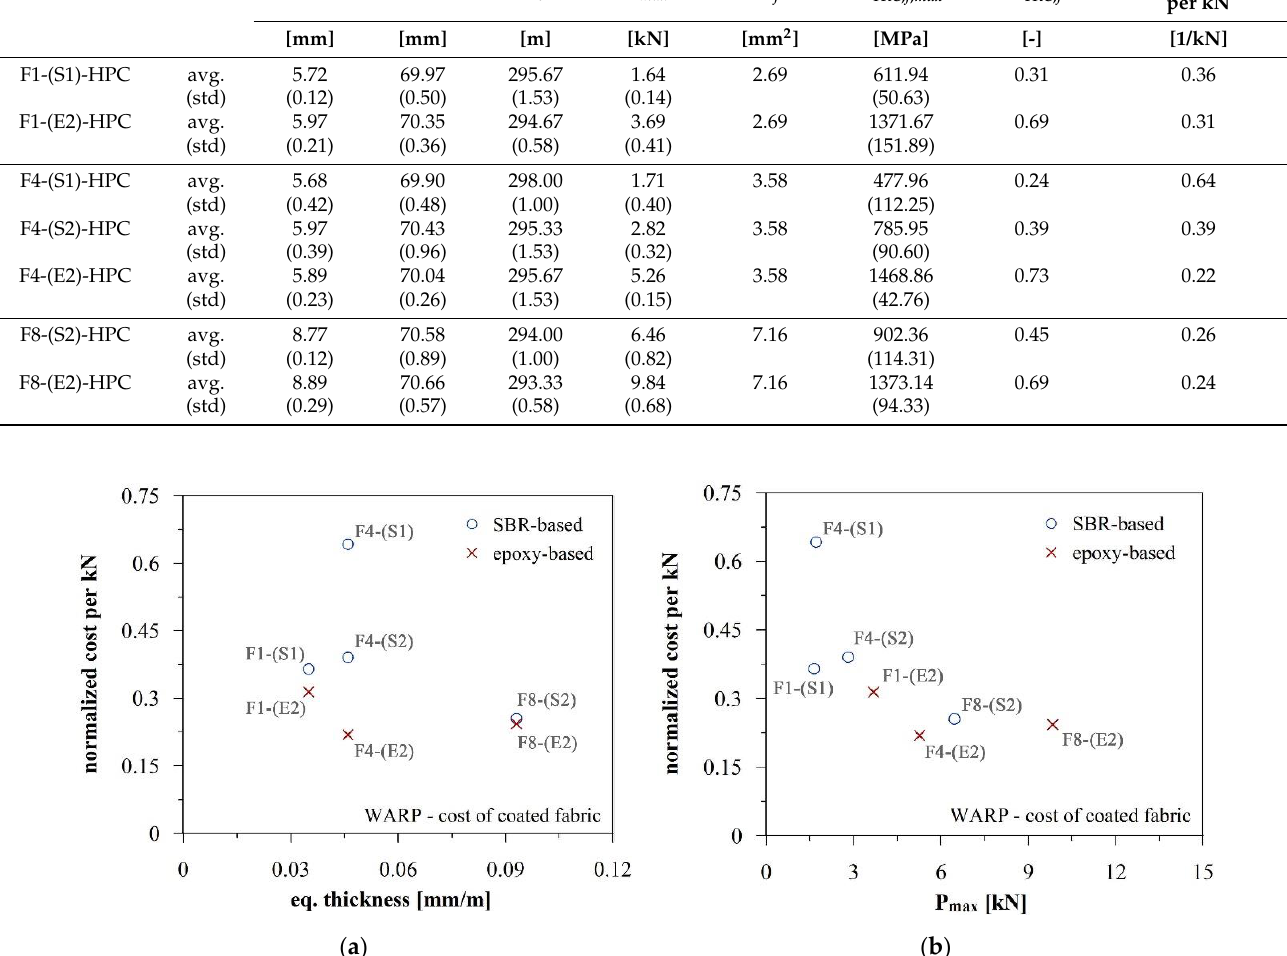
t b L 0 P max the tensile test on the composites. The cost over performance ratio is generally lower in